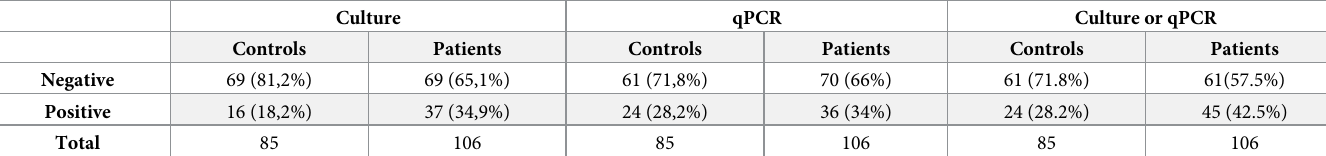
Table 2. Frequency of Trichomonas tenax by qPCR and